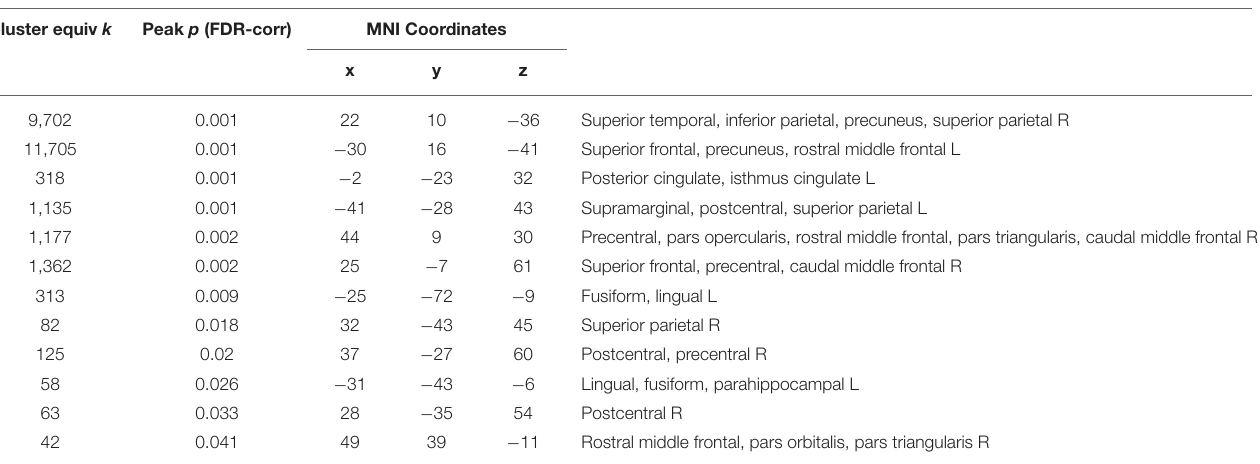
TABLE 4 | Regional brain differences in morphometric profiles between HC and bvFTD patients. Cluster equiv k Peak p